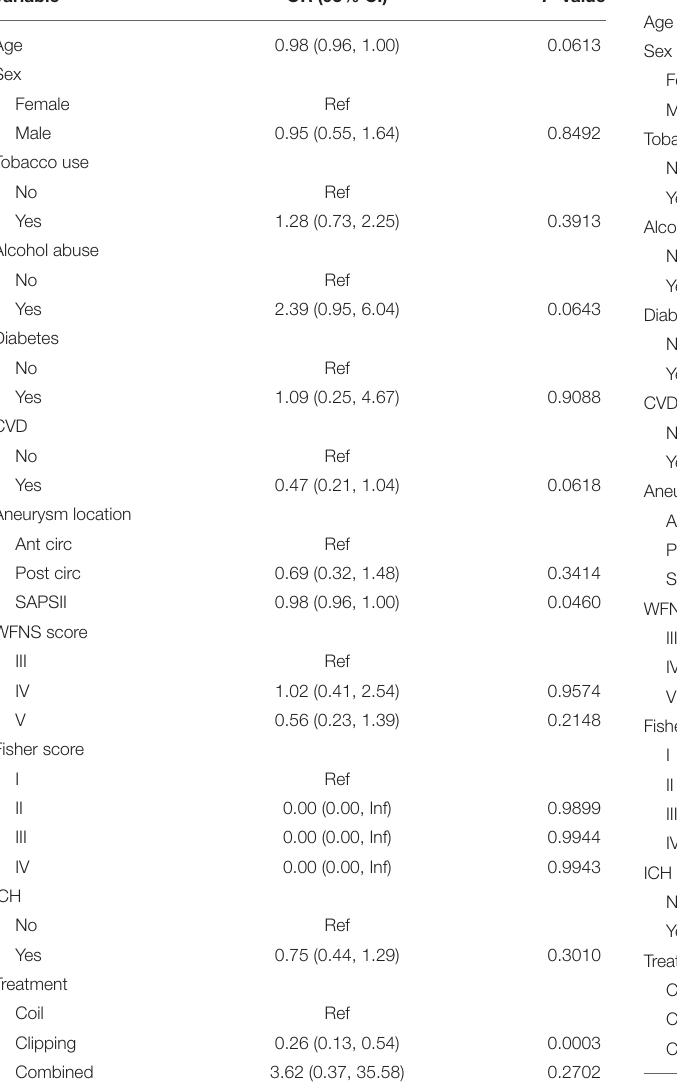
TABLE 2 | Univariate logistic regression analysis of risk factors for angiographic vasospasm. Variable